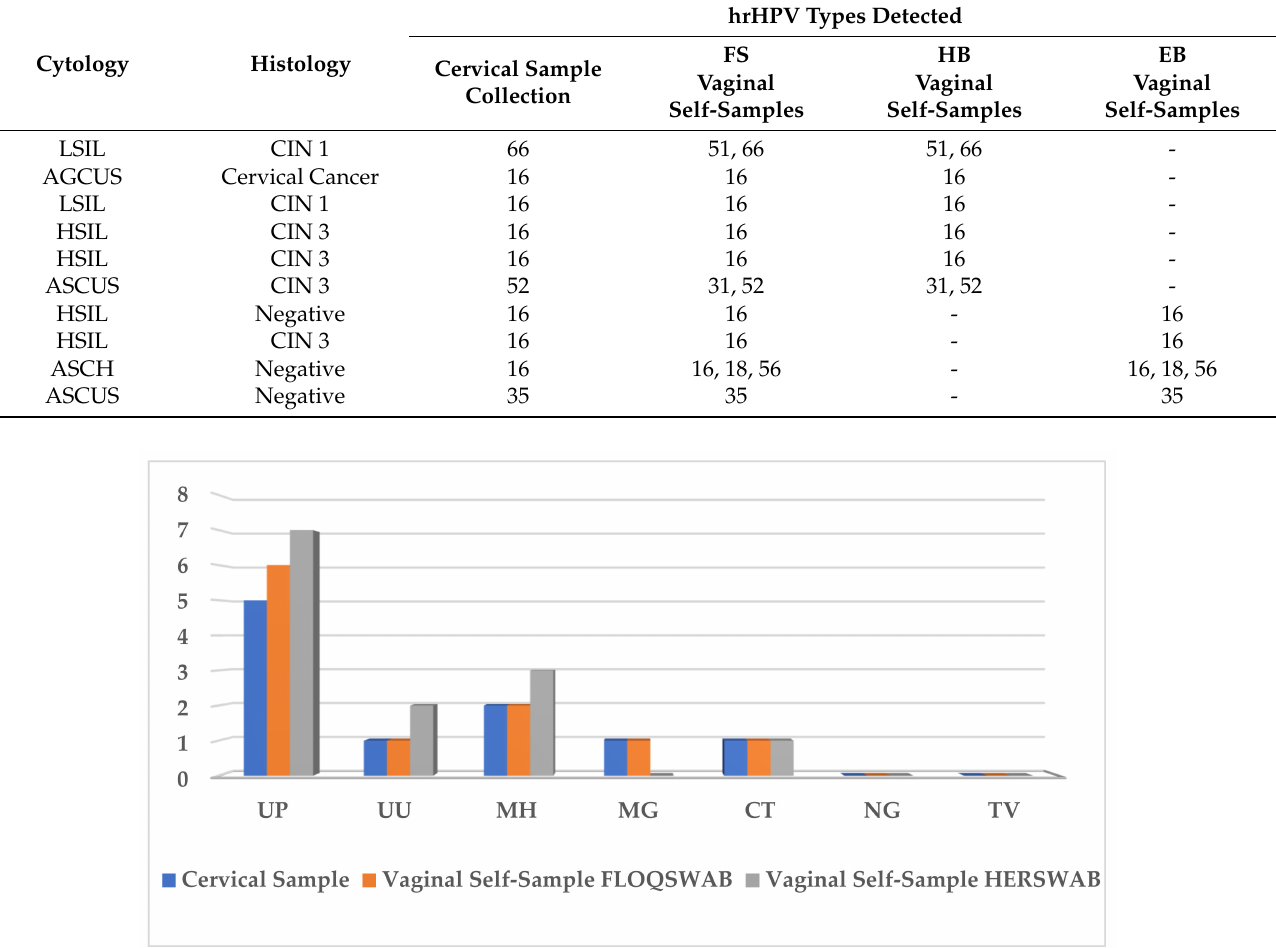
Table 2. NumberofhrHPV-positivecasesinwomenbiopsied,categorizedaccordingtocytologyand histology.